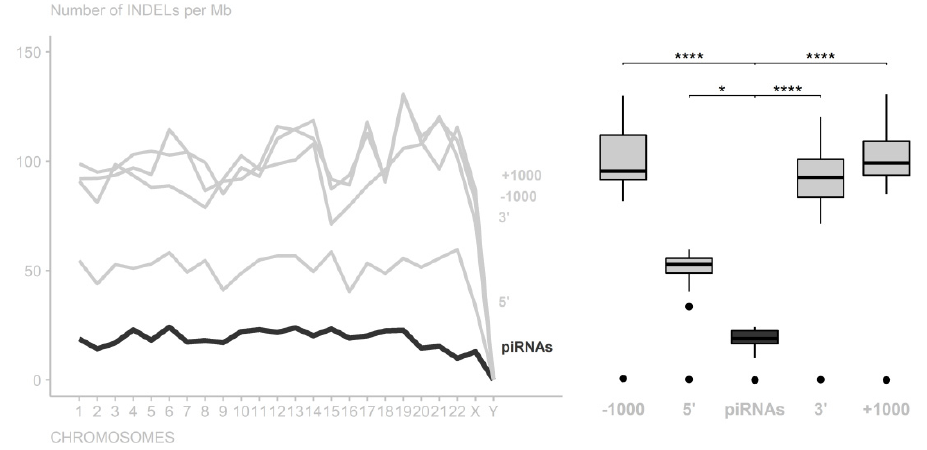
Figure 2. Number of INDELs per 1,000,000 nucleotides in the piRNA regions among their flanking and adjacent regions. In all chromosomes, the piRNAs had the highest conservation level (* p- value < 0.05; **** p- value < 0.0001).